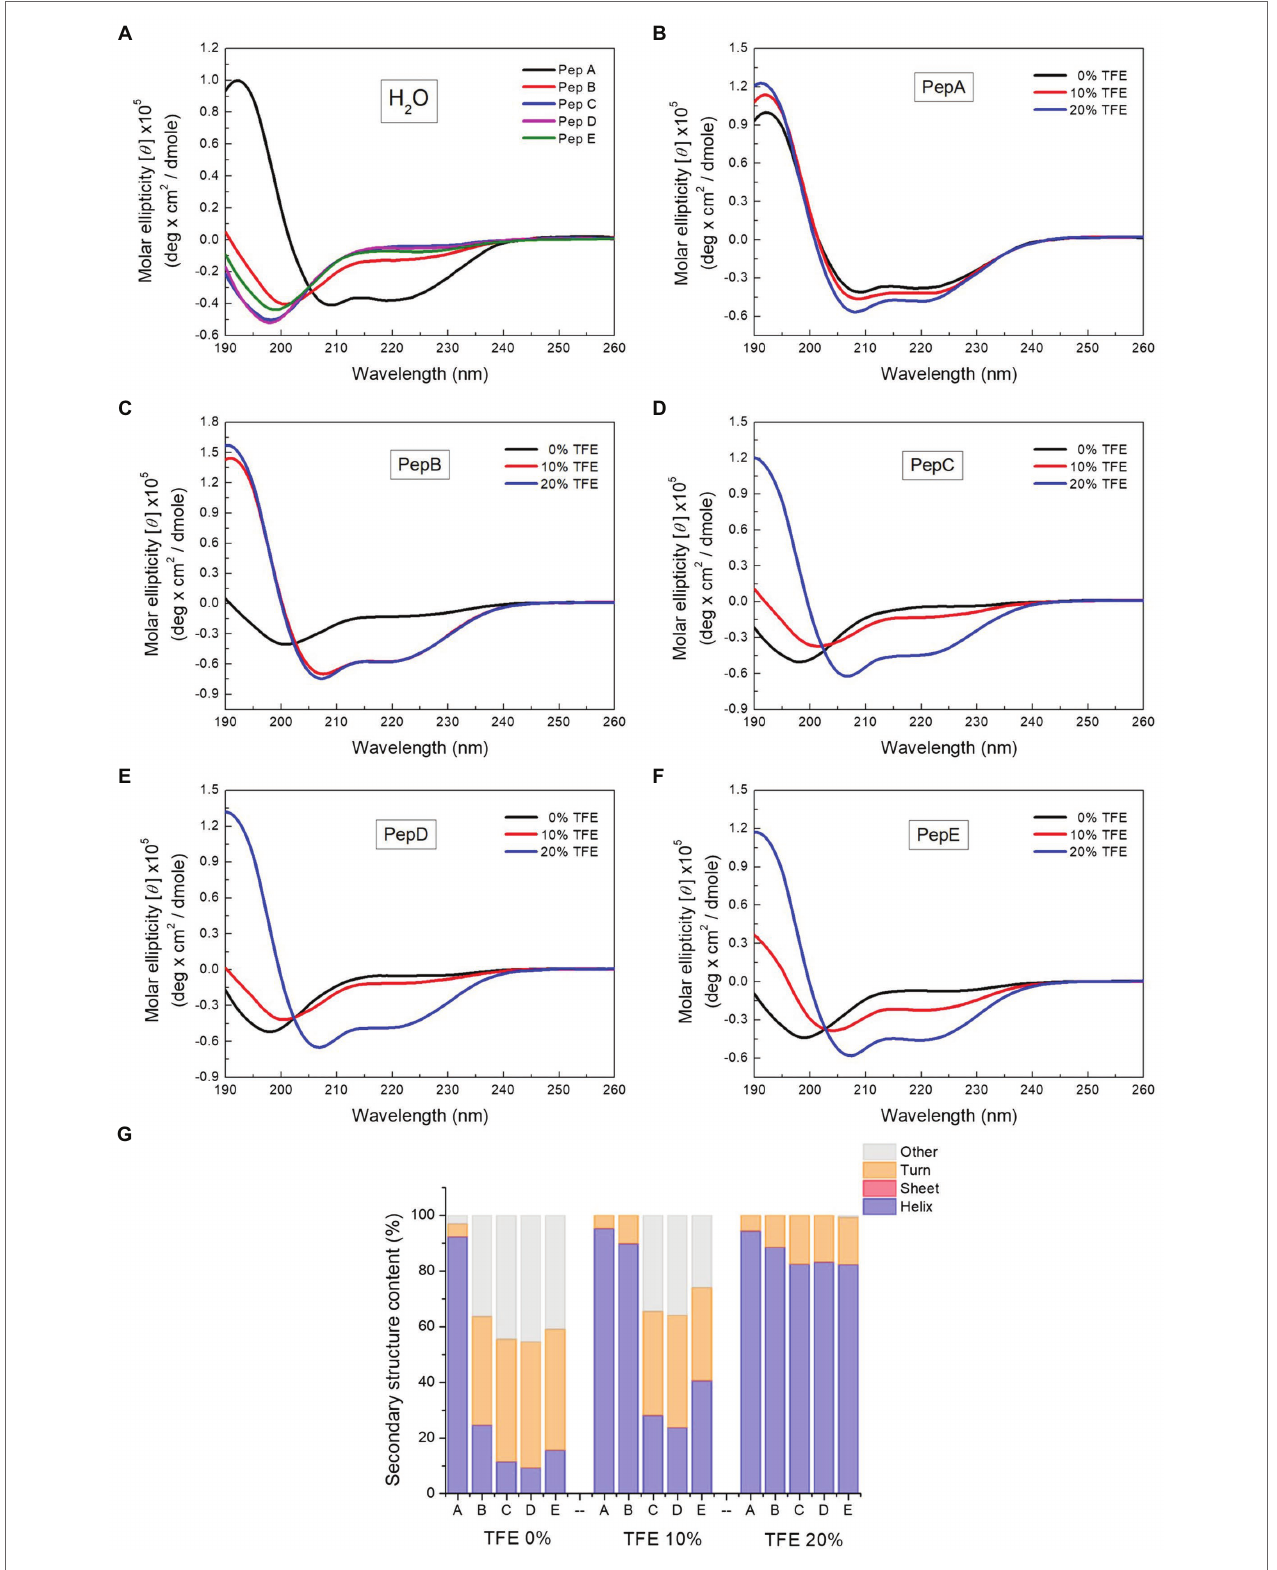
FIGURE 2 | Circular dichroism (CD) spectra of the peptides and the spectrum deconvolution results. (A) CD spectra of pepA, pepB, pepC, pepD, and pepE in water. (B–F) CD spectra of the peptides in water, 10% trifluoroethanol (TFE), and 20% TFE. (G) Secondary structure content of the peptides in water, 10% TFE, and 20%